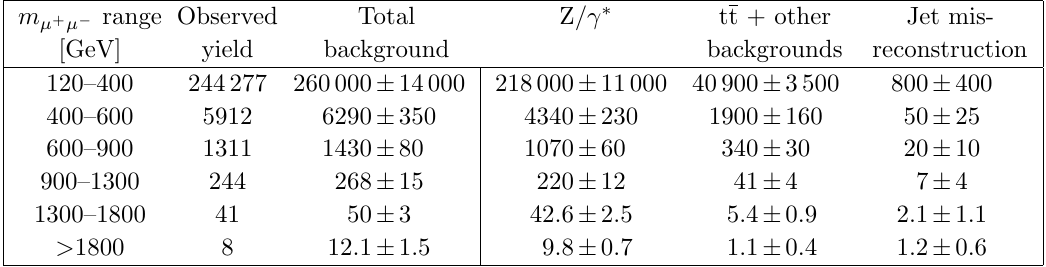
Table 3 . The number of dimuon events in various invariant mass ranges. The total background is the sum of the events for the SM processes listed. The yields from simulation are normalized relative to the expected cross sections, and overall the simulation is normalized to the observed yield using the number of events in the mass window 60{120 GeV, acquired using a prescaled low threshold trigger. Uncertainties include both statistical and systematic components, summed in